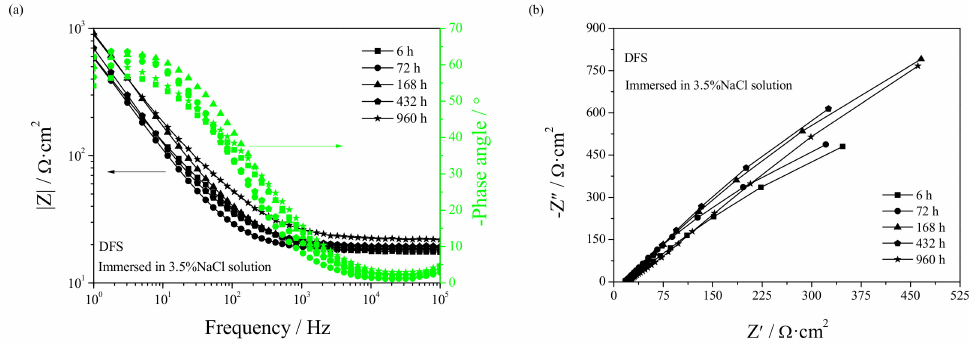
Figure 12. Bode ( a ) and Nyquist ( b ) plot of DFS immersed at di ff erent times in 3.5% NaCl